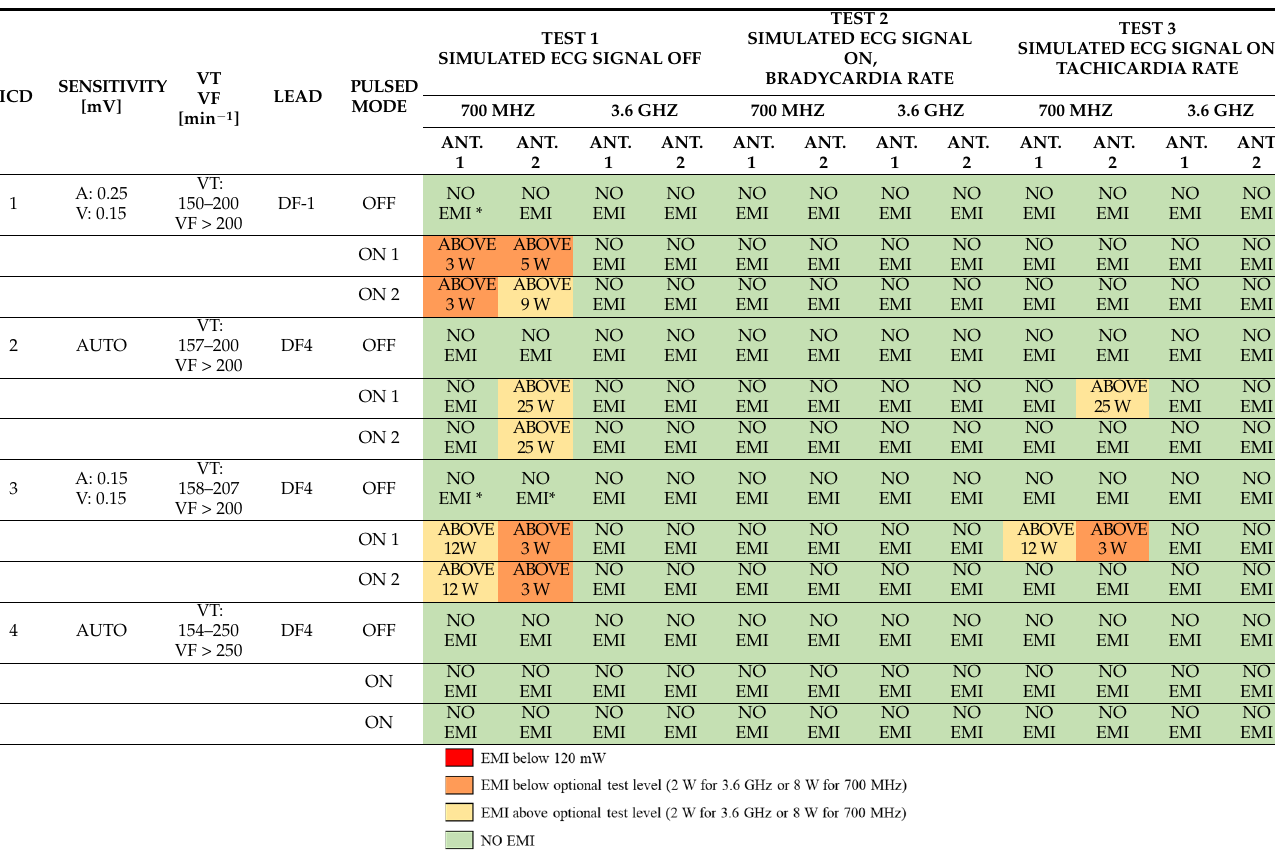
happened only in ICD #1. Table 5. ICD results, bipolar sensing (power threshold levels are reported rounded to the nearest integer in terms of Watts).